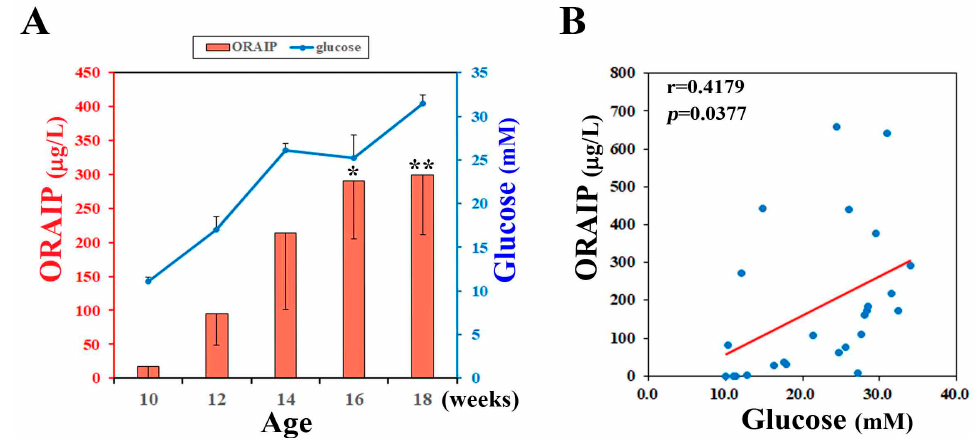
Figure 1. ( A ) Plasma levels of ORAIP (Oxidative stress-Responsive Apoptosis Inducing Protein) (red bar graph, left Y-axis) and those of glucose (blue line graph, right Y-axis) in ZFDM rats (mean ± SE, n = 5, * p = 0.0257 and ** p = 0.0177 vs. 10-week-old; paired t -test); ( B ) Correlation between plasma levels of ORAIP and glucose. There was a significant positive correlation ( r = 0.418, p = 0.0377). A red line indicates the regression line.